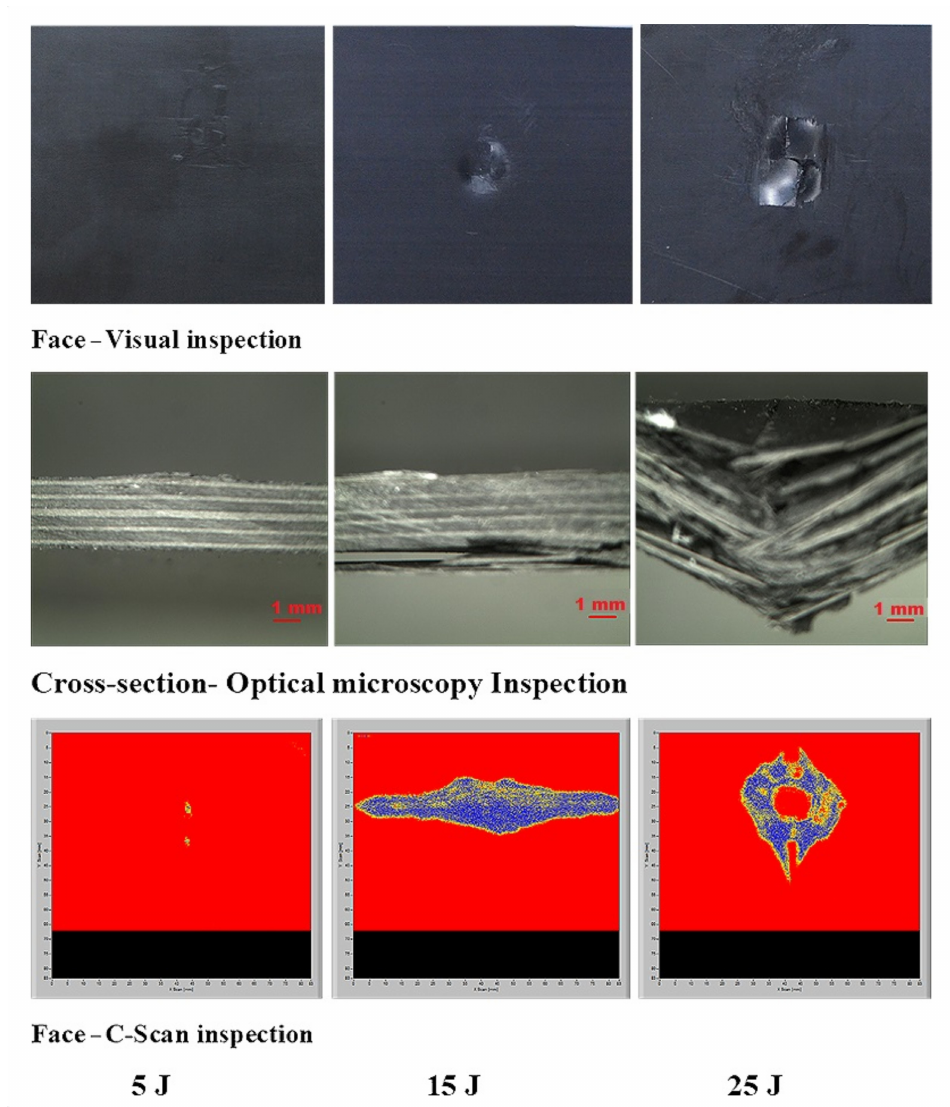
Figure 16. Pictures of the top surface view with visual, C-scan, and cross-section with optical microscopy of [A/A] at 5, 15, and 25